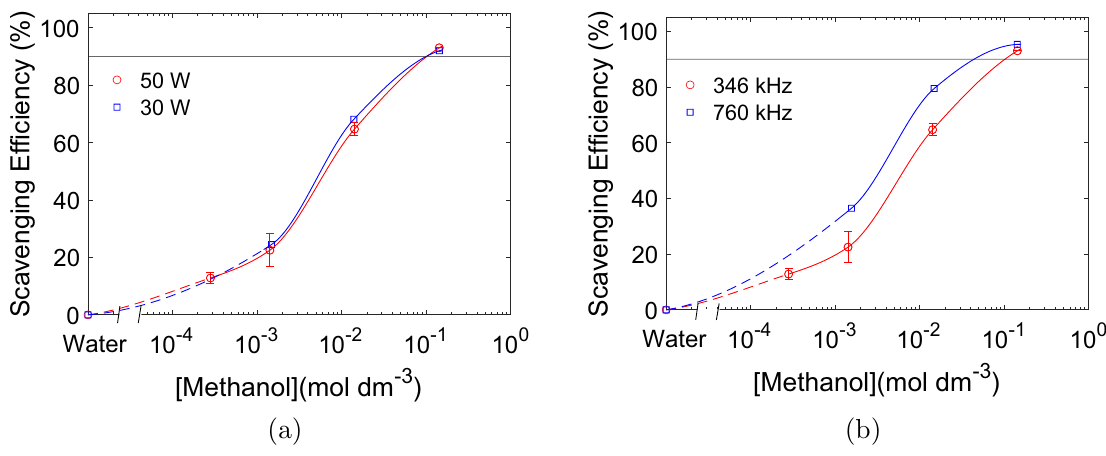
Figure 5. Scavenging efficiency of · OH radicals as a function of methanol concentration for applied electrical powers of 50 W ( (cid:31) ) and 30 W ( (cid:31) ) ( a ), and for applied ultrasonic frequencies of 346 kHz ( (cid:31) ) and 760 kHz ( (cid:31) ) ( b ). The power experiments in ( a ) were acquired at an applied ultrasonic frequency of 346 kHz, while the frequency experiments in ( b ) were acquired at an applied electrical power of 50 W. Solid and dotted lines are drawn with spline interpolation to guide the eye. The horizontal lines at 90% represents the upper detection limit for the scavenging